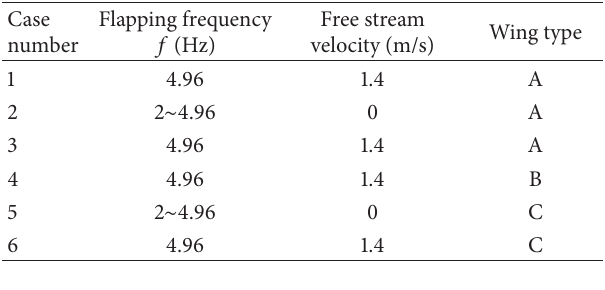
Table 1: Specification of flapping wing model.